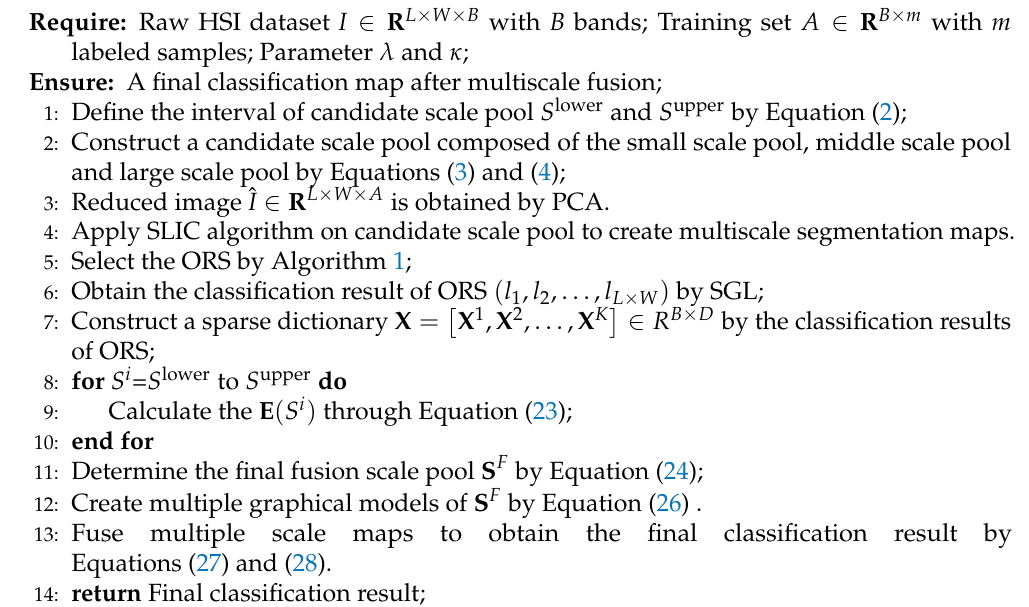
Algorithm 2 The proposed